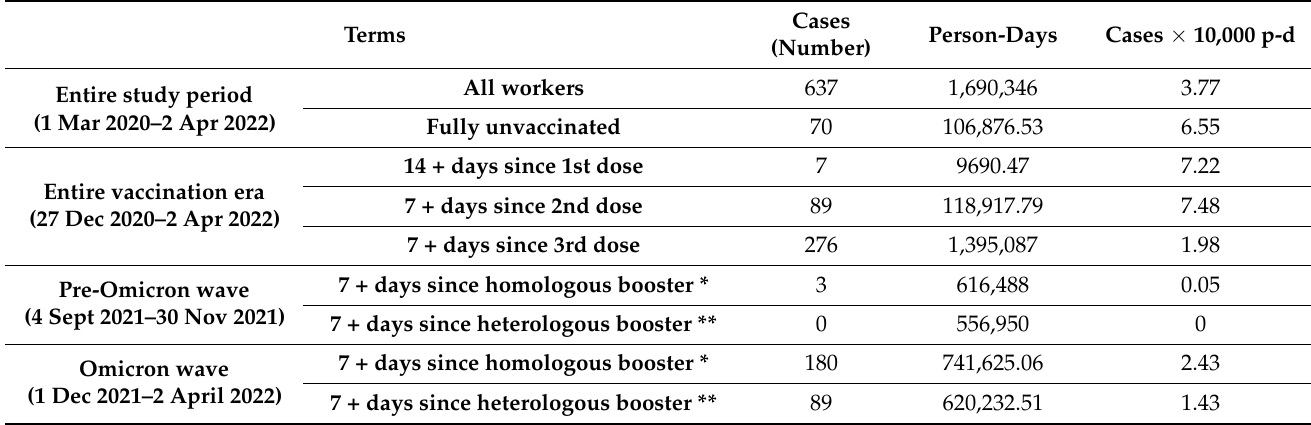
Table 4. Crude incidence rates of primary SARS-CoV-2 infections during 1 March 2020–30 April 2022 by explanatory factors. Number of cases, person-days (p-d) at risk and raw incidence ( × 10,000